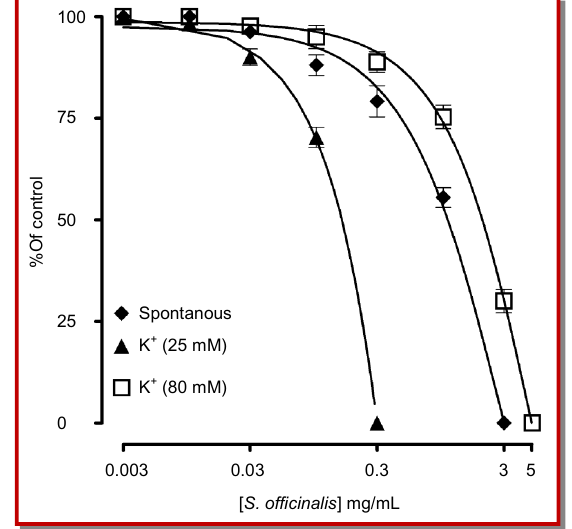
Figure 2: Inhibitory effect of the crude extract of S. officinalis crude extract, on spontaneous, low K + (25 mM) and high K + (80 mM)-induced contractions in isolated rabbit jejunum prepara- tions. Symbols represent mean ± SEM; n =